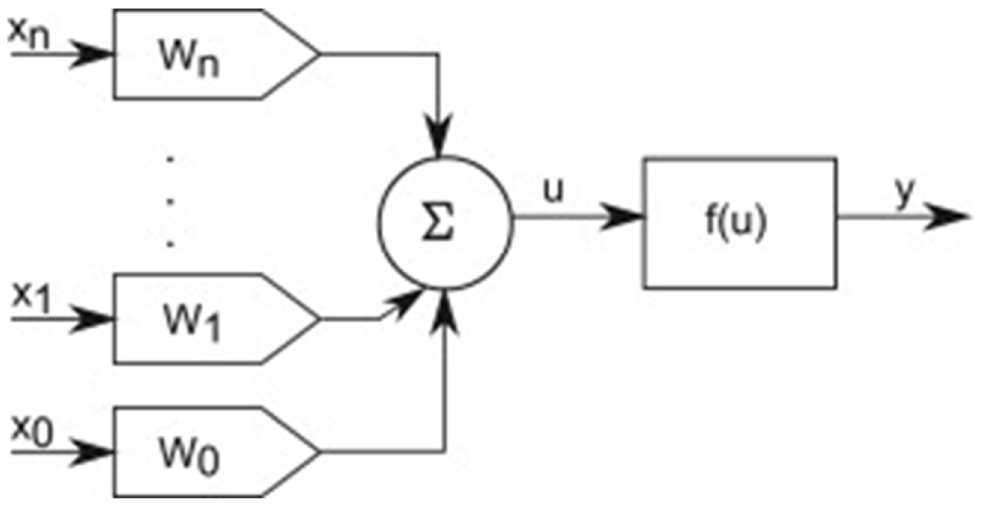
Figure 5. Scheme for application of ANN in kinetics modeling.